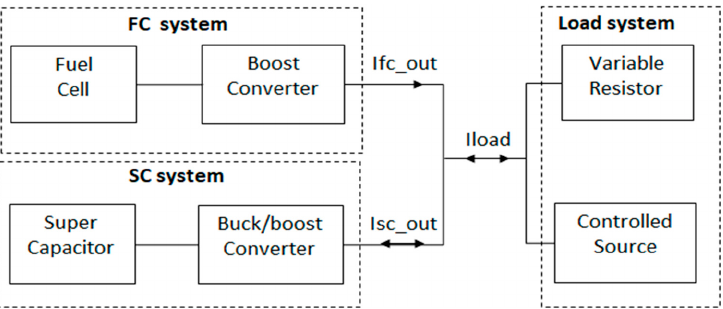
Figure 1. System configuration of the computational model.